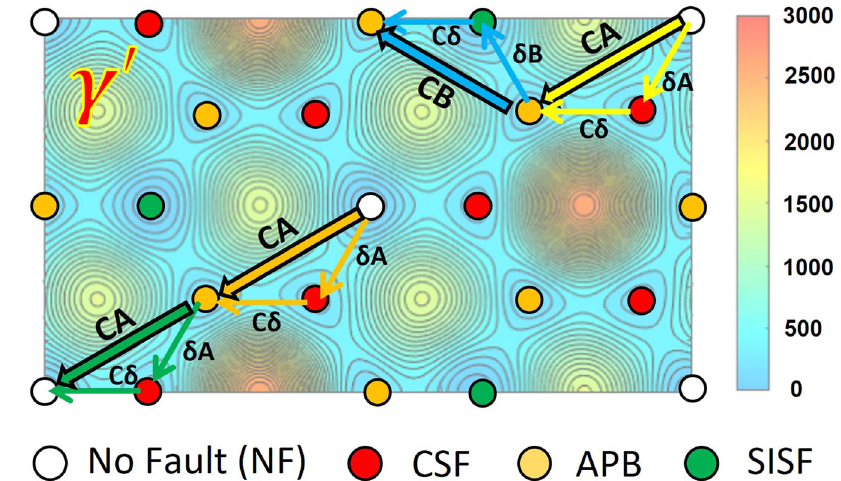
Fig. 4 Deformation pathways of CA + CA and CA + CB dislocation groups in the γ ′